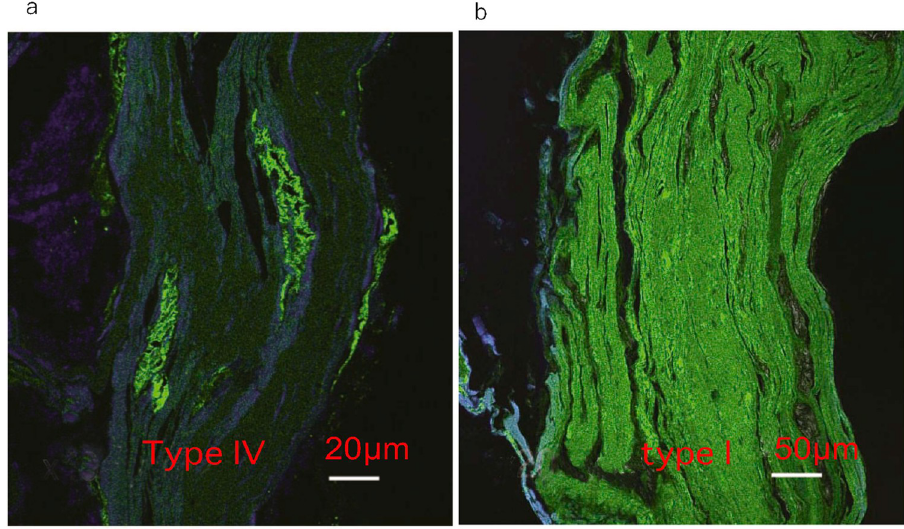
Fig 5. Immunofluorescence observation of mammoth soft tissues. (a) Masha’s lung stained by anti-type IV collagen antibody. (b) Masha’s lung stained by anti-type I collagen antibody.